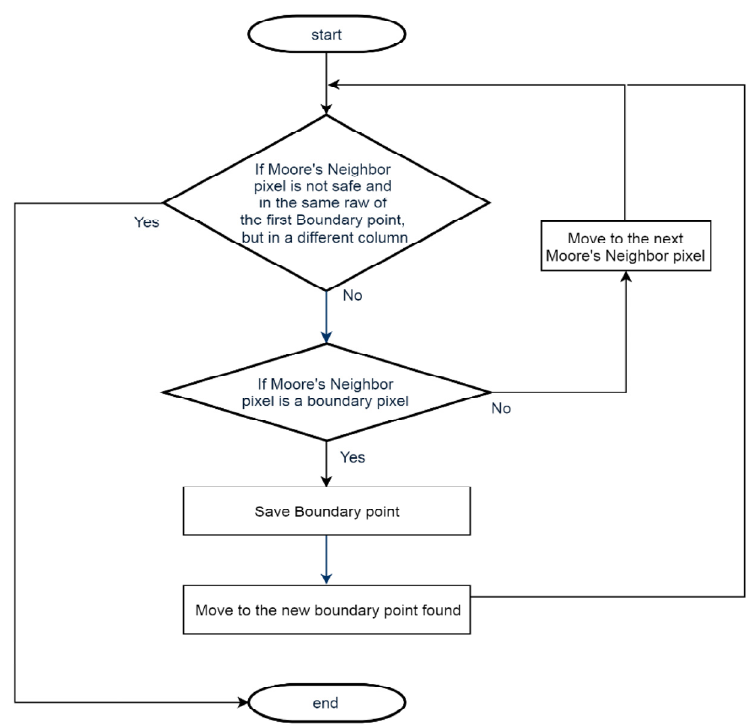
Figure 5. Boundary point avoidance fl owchart.